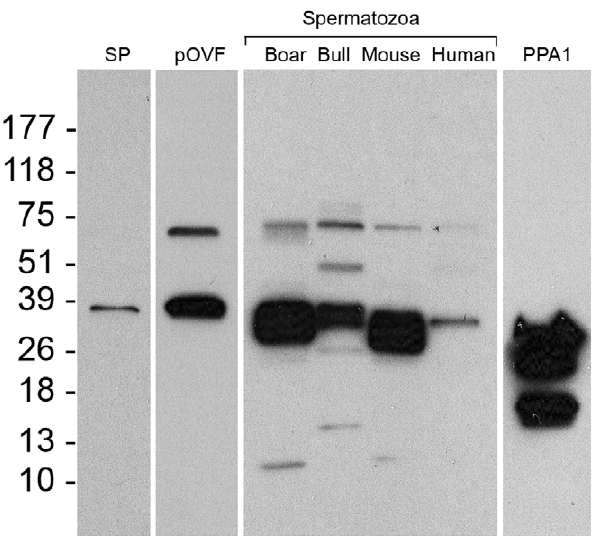
Figure 4. Detection of inorganic pyrophosphatase (PPA1) by Western blotting. Boar seminal plasma (SP; 20 m g/ml), porcine oviductal fluid (pOVF; 100 m g/ml), and boar, bull, mouse and human spermatozoa (all at 1 6 10 6 spermatozoa/ml) were extracted to perform the protein analysis. Equal protein loads were used. Distinct band at , 32 kDa was detected by rabbit polyclonal anti-PPA1 antibody. The purified PPA1 (extreme right lane; 1 m g/ml; Sigma I1643) from S. cerevisiae was used as a control protein.